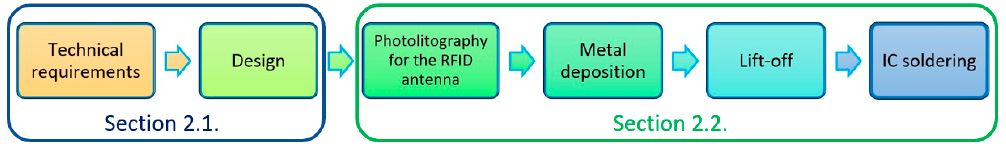
Figure 2. Main stages for the development of an RFID antenna.